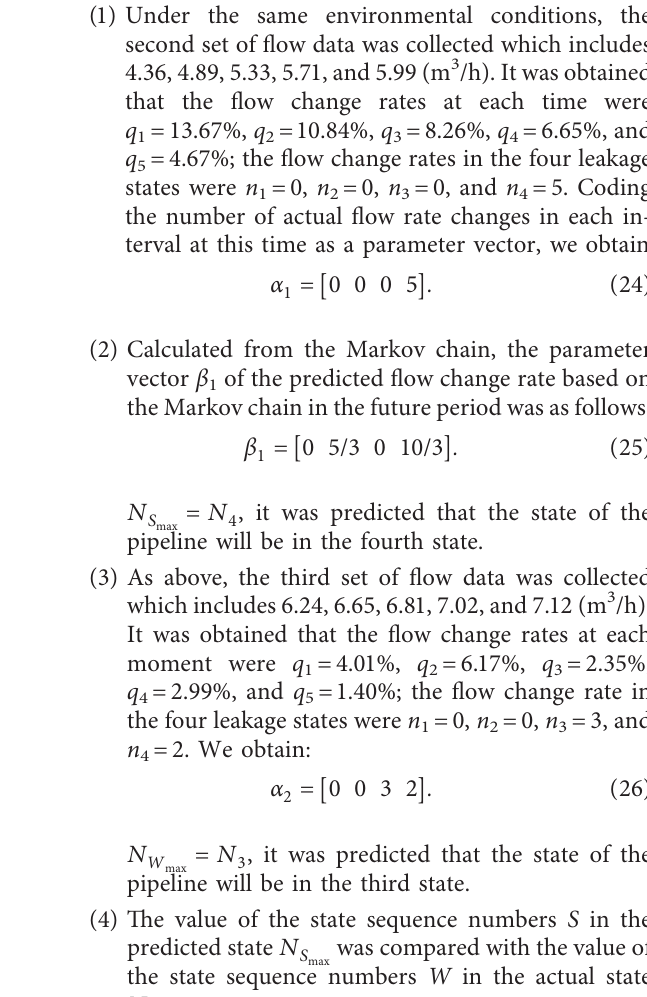
Figure 7: Pressure and flow data collection at 0.3 MPa